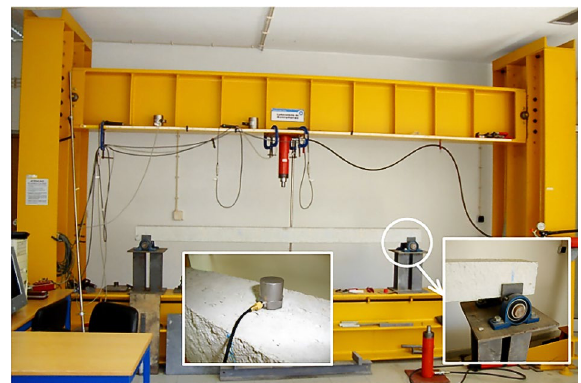
Fig. 4. Experimental dynamic setup